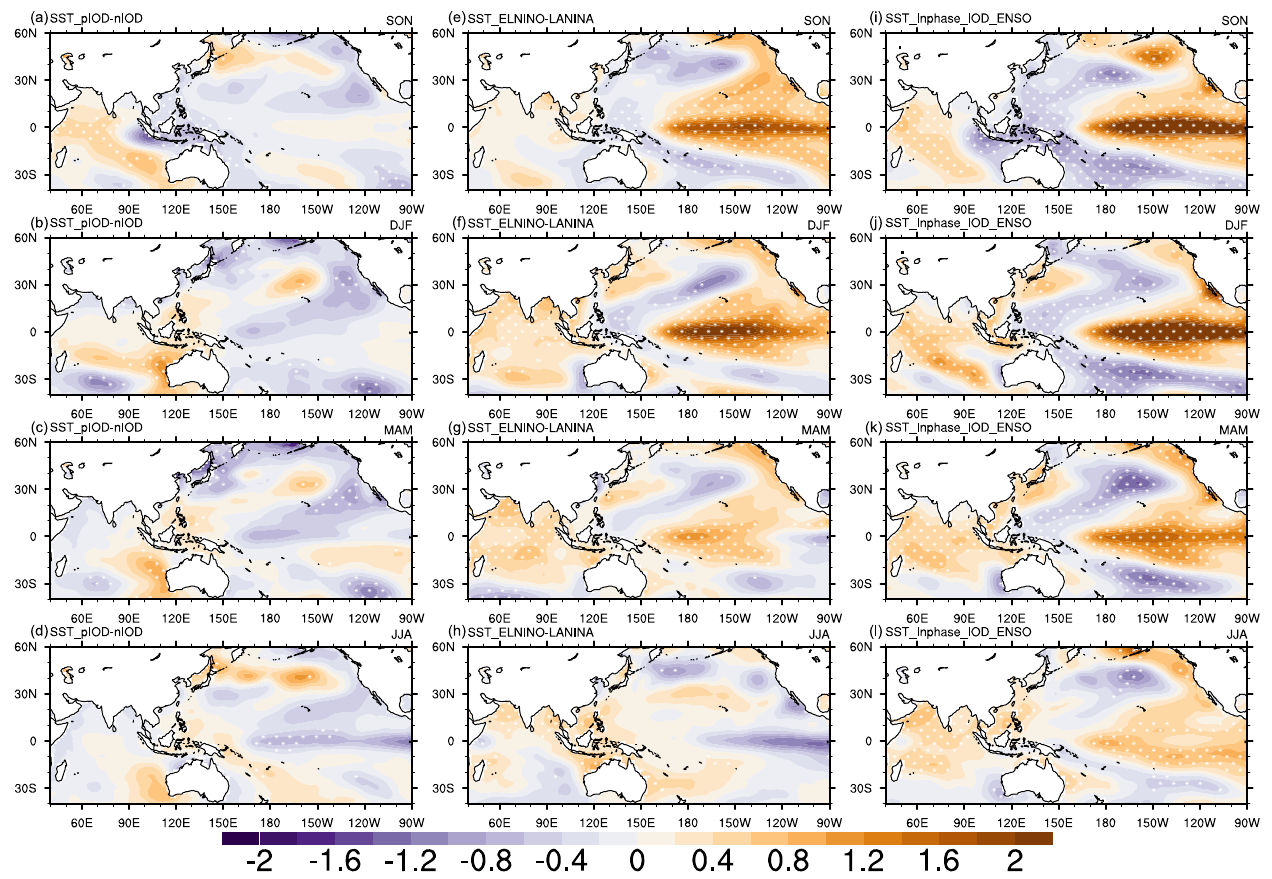
Fig. 3 Seasonal evolution of SST patterns in association with IOD and ENSO. Composite seasonal evolution of SST anomalies (contours, °C) from autumn to the ensuing summer based on the years when a – d only IOD occurs, e – h only El Niño occurs, and i – l IOD and ENSO occur together. Dotted areas have statistical signi fi cance at the 95% con fi dence